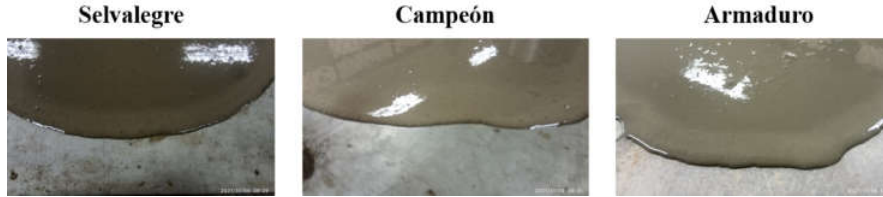
Figure 8. Mini-cone tests of selected F3-CEMs. BS sand. / = 0.30 . 2.0 %cw Viscocrete. Table 11. Tests using the Abrams mini cone of equivalent mortar detailed in Tables 8–10, with nor- malized concrete according to the recommendation of Colegio Oficial de Ingenieros Civiles (Quito, Ecuador) was selected (Table 3).